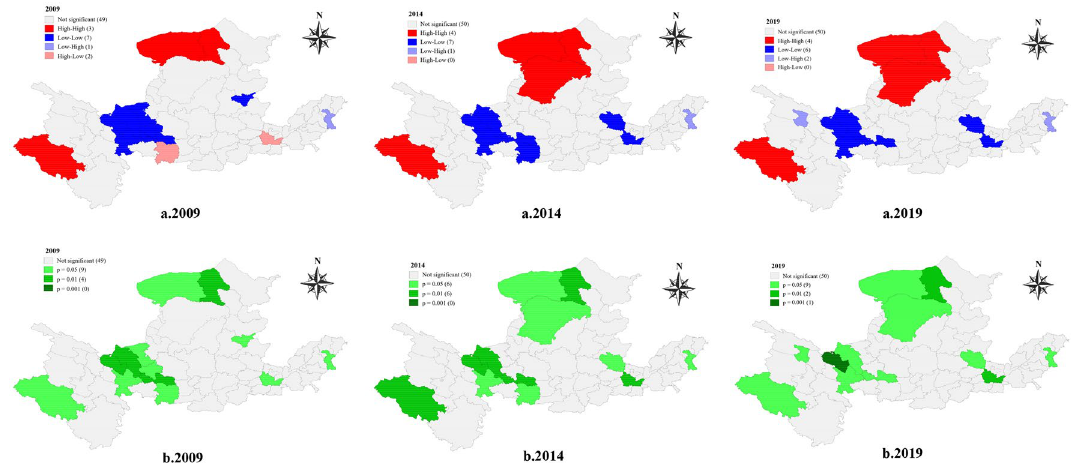
Figure 7. (a) LISA cluster map of water ecological safety in 62 cities in 2009, 2014, and 2019, ( b) LISA significance map of water ecological security of 62 cities in 2009, 2014, and 2019. Note This was created by Geoda, version 1.18.0. https:// geoda center. github. io/.